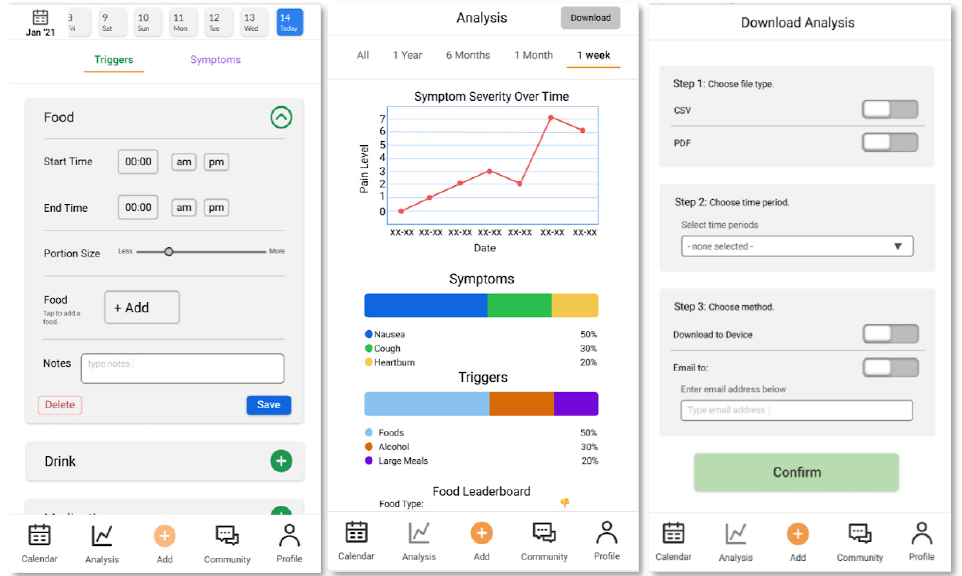
Figure 4. Pages from final medium-fidelity prototype. From left to right: calendar page, analysis page, export feature, trigger/symptom input page, food trigger ingredient input page, and user profile page.